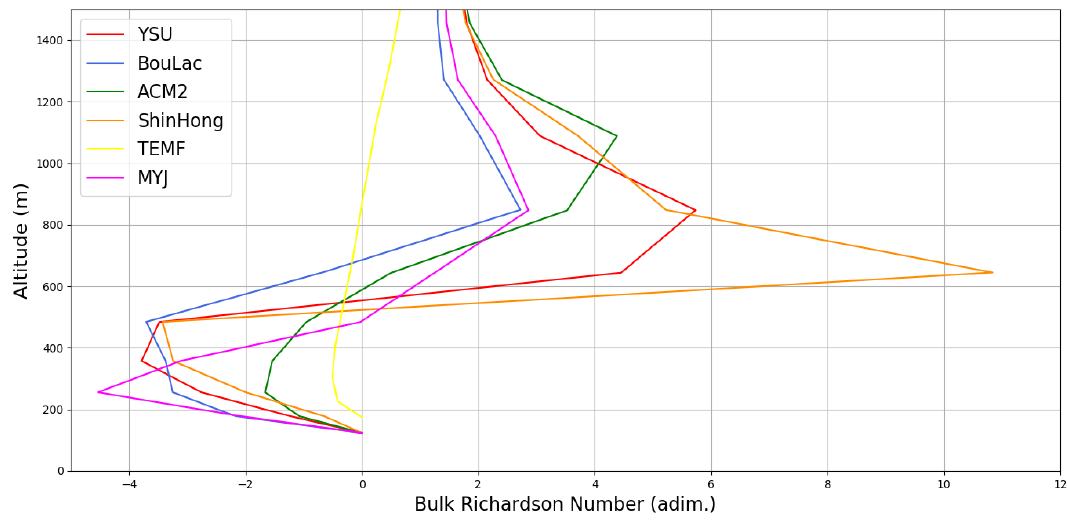
Figure 18. Simulated bulk Richardson number profiles compared with one another, 04/04/2016, 09:30, red: simulated data with YSU parametrization, blue: simulated data with BouLac parametrization, green: simulated data with ACM2 parametrization, orange: simulated data with ShinHong parametrization, yellow: simulated data with TEMF parametrization, purple: simulated data with MYJ parametrization.